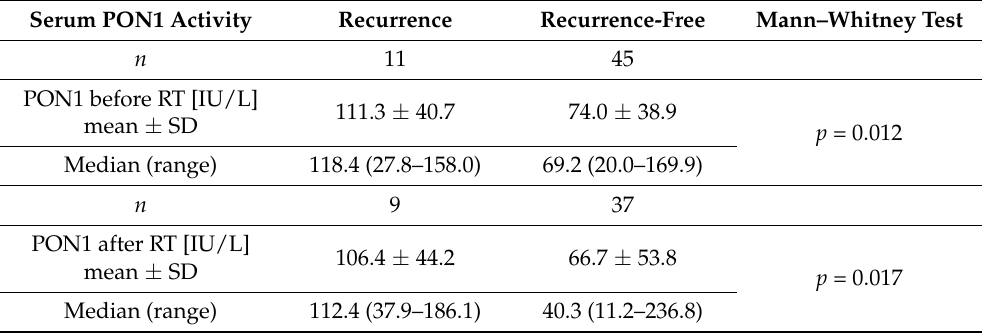
Table 3. Serum paraoxonase-1 (PON1) activity before and after radiotherapy in prostate cancer patients who experienced recurrence after treatment and in patients who remained recurrence-free.